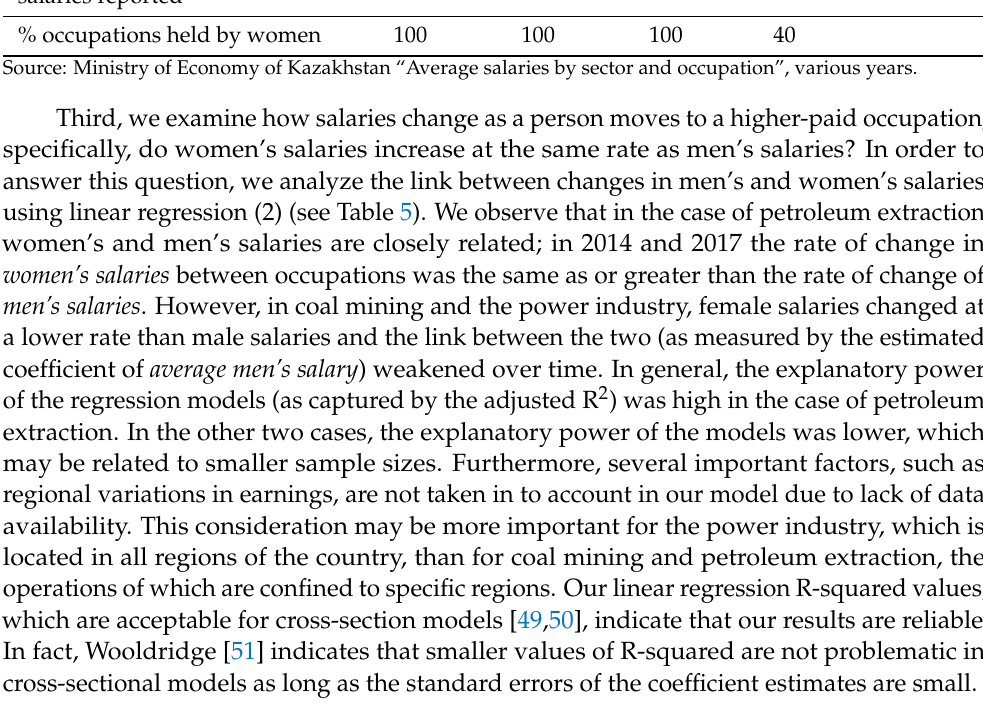
Table 5. Regression results: determinants of women’s